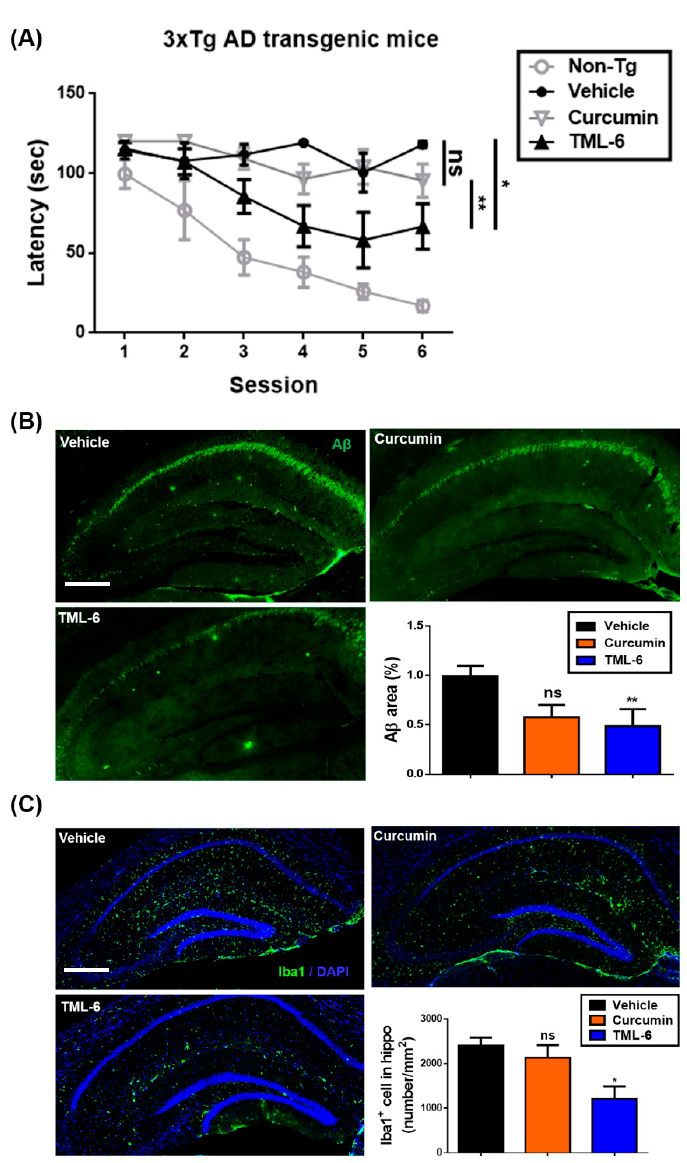
Figure 4. TML-6 improved the behavior test and reduced the brain levels of A β and the inflammatory biomarker Iba1 in the 3x-Tg AD mouse model. (A) Six-month old 3x-Tg AD mice were fed with normal diets (vehicle), or diets containing traditional curcumin and TML-6 for four months at a dosage of 150 mg/kg (each group contained five mice, n = 5). After four months of treatment on the experimental diet, animals were subjected to a behavior test in the form of the Morris water maze. The figure shows data from vehicle, curcumin and TML-6 fed different chow diets, with triplex-Tg AD mice and non-transgenic mice (Non-Tg) serving as the control. (B) The A β levels in mouse brains in 3x-Tg AD mice were examined at the end of behavior test after four-month feeding with the treatment of normal diets, traditional curcumin and TML-6. Mouse brain sections were examined by immunofluorescence staining. The immunofluorescence staining of A β was quantified and is represented in the panel. Scale bar: 200 μ m. (C) Mouse brain sections were also examined for the inflammatory biomarker Iba1 by immunofluorescence staining. The images of Iba-1 levels were represented and quantified as indicated in the panel. The significance of the behavior test, A β , and Iba-1 levels between the mice treated with normal diets (vehicle) and either curcumin or TML-6 was determined by paired t-test. Asterisks denote data representing the mean with a standard deviation (SD) error bar, and p value < 0.05 was considered significant (* p < 0.05 and ** p < 0.01).